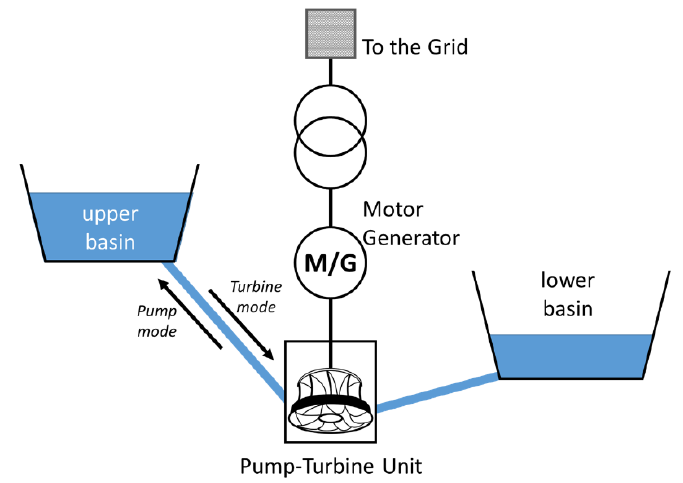
Figure 1. Basic concept of Pumped Hydro Storage.